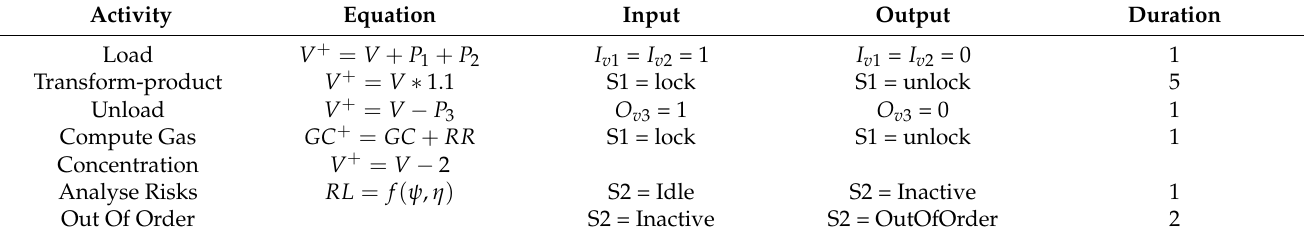
Table 5. Activities equations.